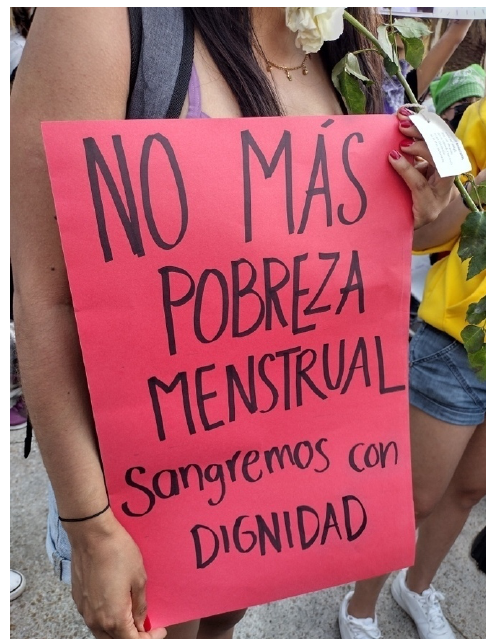
Figure 4 – Source: Olga Sabido Ramos (No More Period Poverty. Bleed with Dignity). 8 March 2022, Mexico,